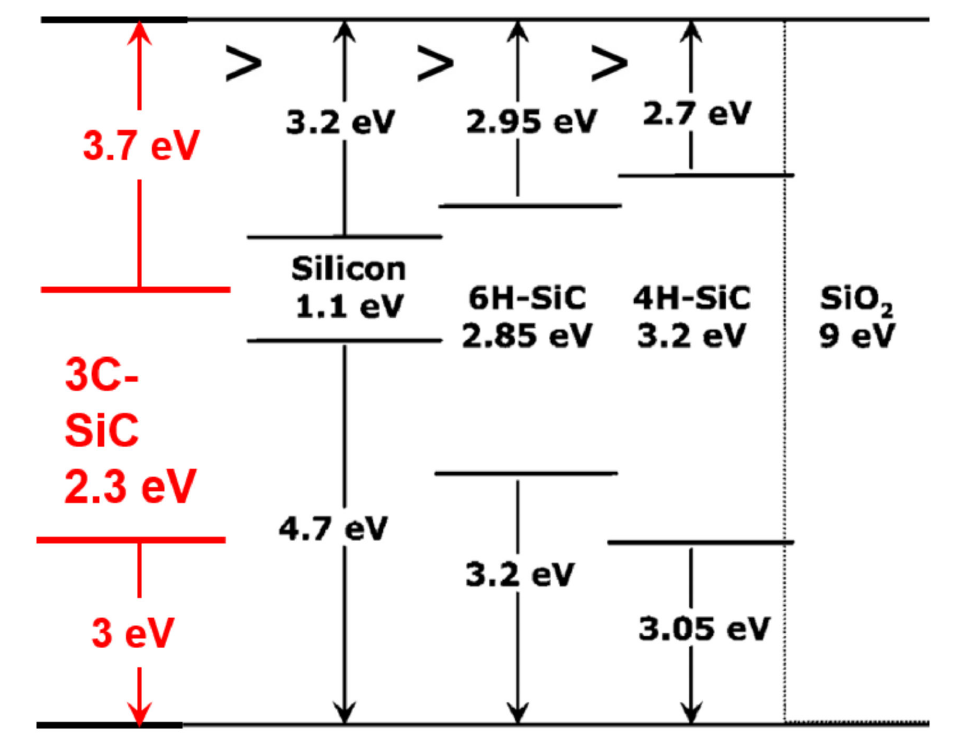
Figure 1. Major power semiconductors’ band structure for 3C-SiC, 4H-SiC, 6H-SiC and silicon, illustrating band offsets with silicon dioxide (SiO 2